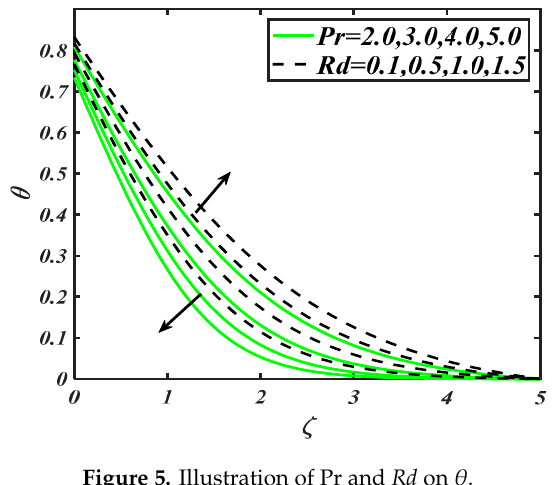
Figure 5. Illustration of Pr and Rd on θ .